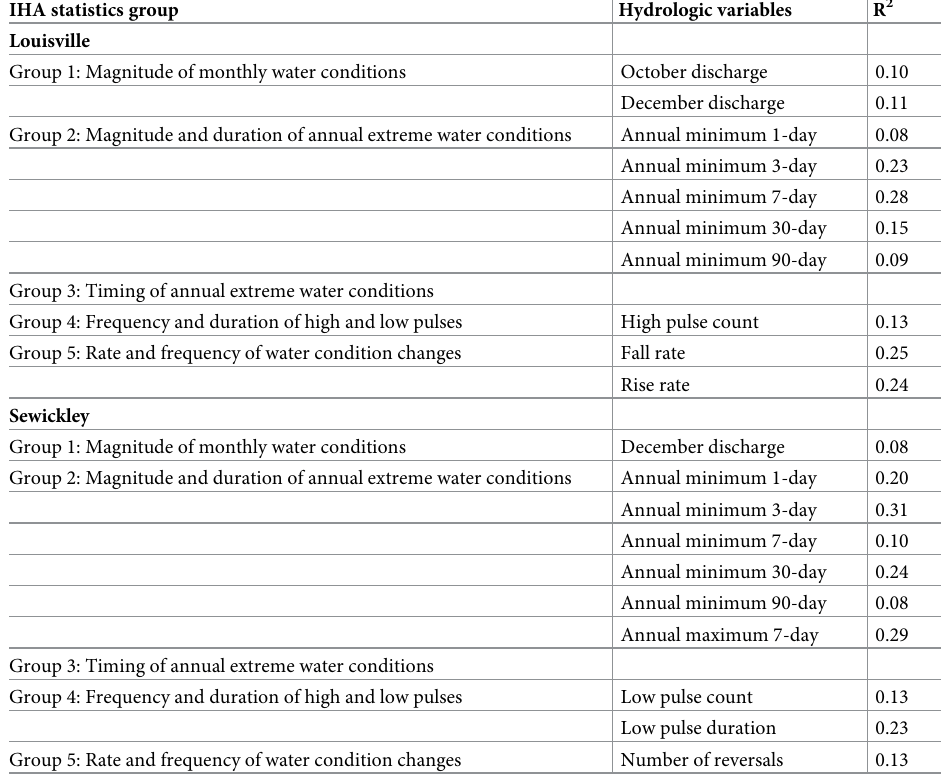
Table 1. Hydrologic variables that that exhibited evidence of temporal trends during 1957–2014, for Louisville (top) and Sewickley (bottom) USGS gage data. IHA statistics